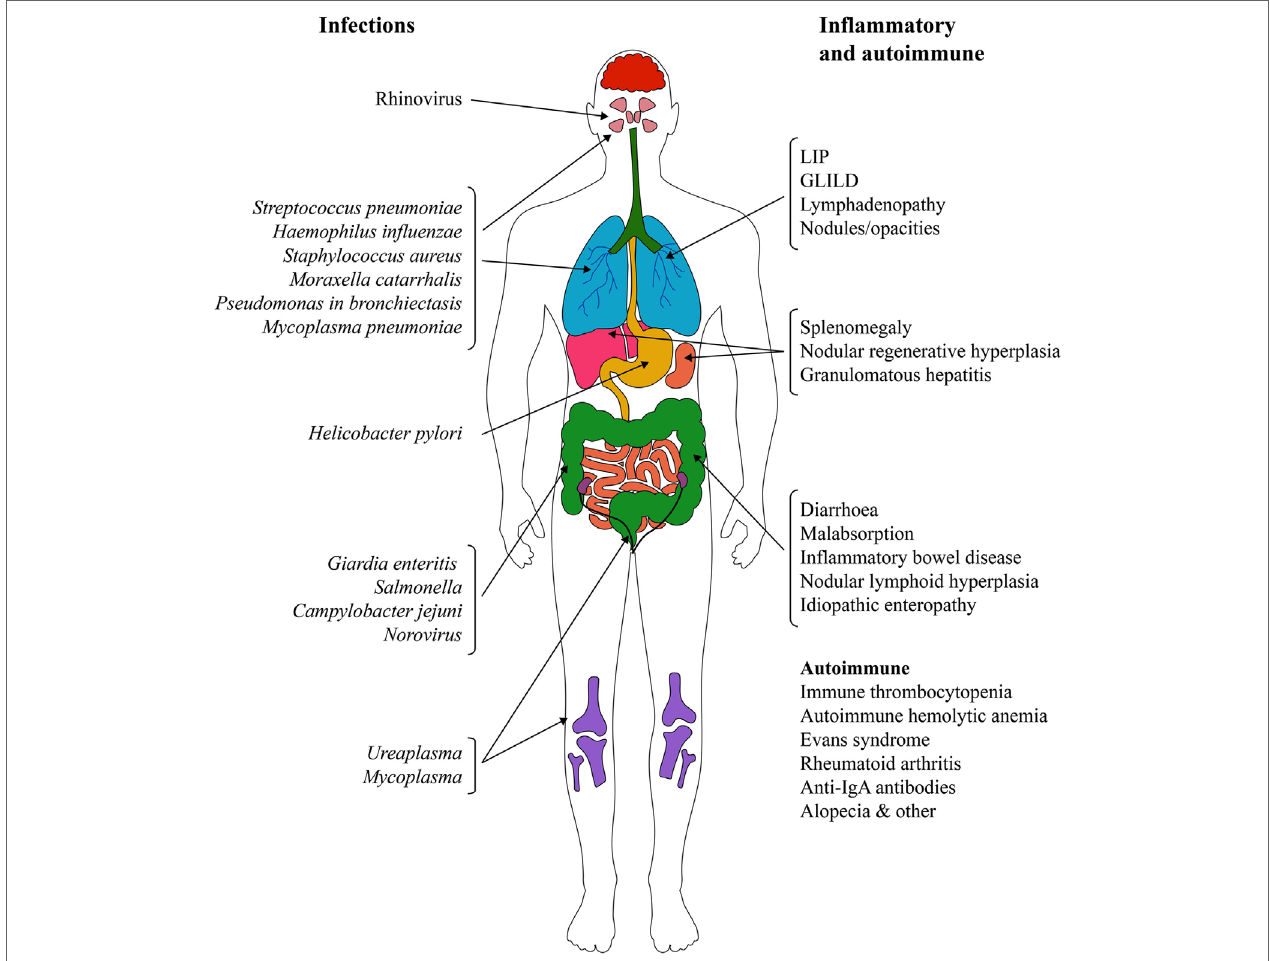
FigURe 2 | Infectious and non-infectious complications in primary antibody deficiencies. Abbreviations: GLILD, granulomatous-lymphocytic interstitial lung disease; IgA, immunoglobulin A; LIP, lymphocytic interstitial